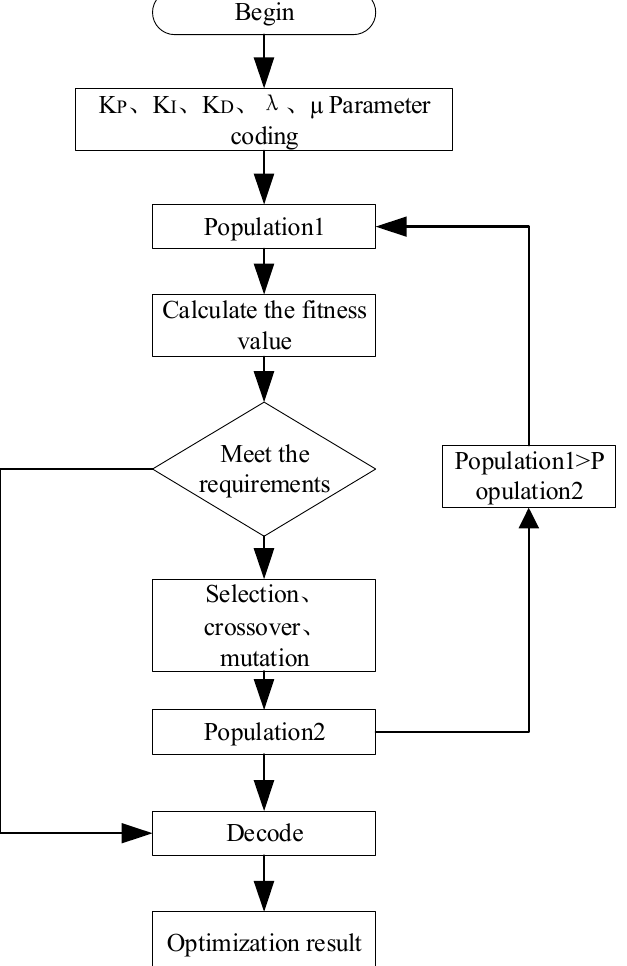
Figure 4. Genetic algorithm PID optimization flow chart.